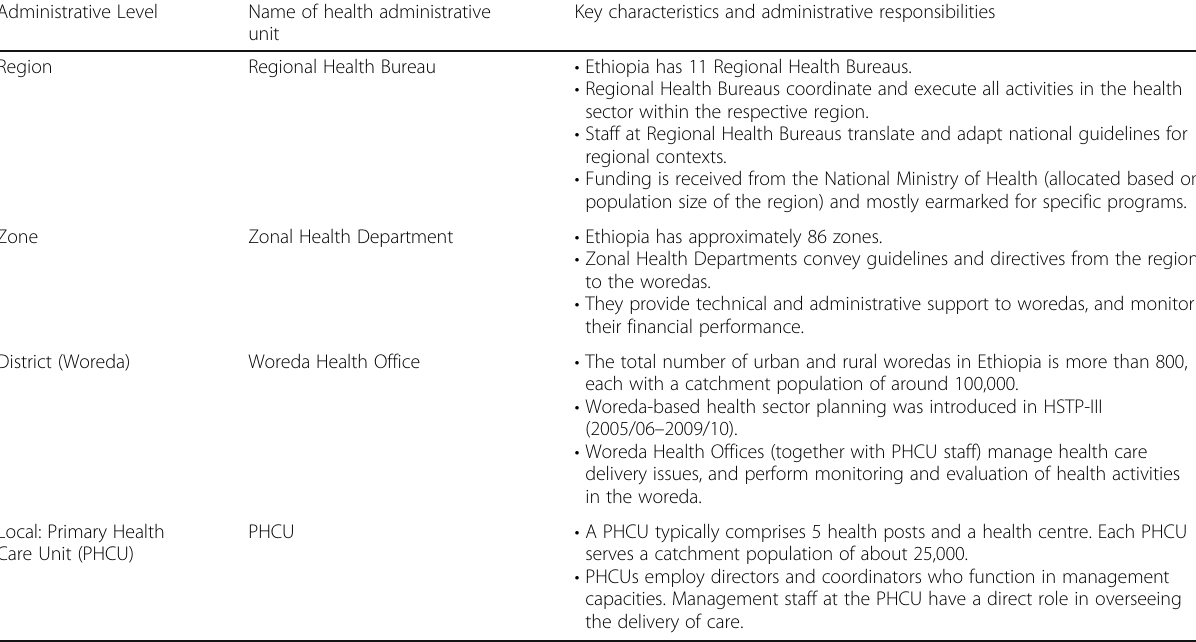
Table 1 Subnational administrative bodies within the Ethiopia system, regional to local, in the Ethiopian health system Administrative Level Key characteristics and administrative